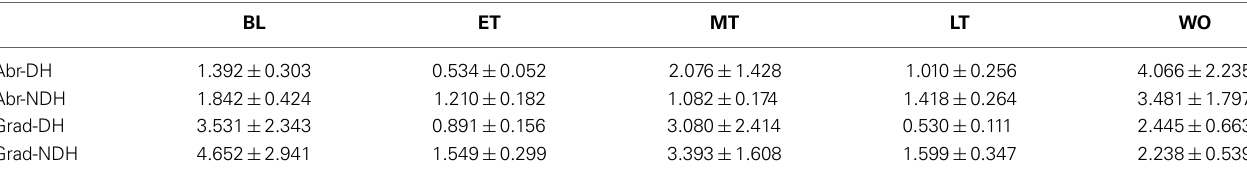
Table 3 | Squared errors (an index of movement accuracy) from the baseline block (BL), early training block (ET), middle training block (MT), late training block (LT), and the washout block (WO).